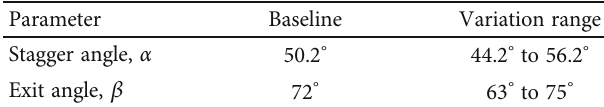
Table 2: Studies